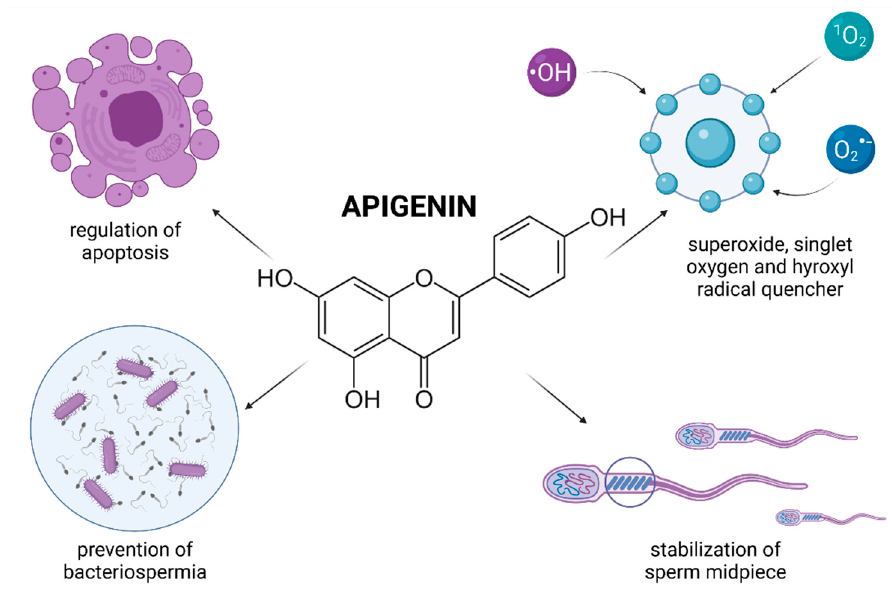
Figure 8. Most frequently reported beneficial effects of apigenin on spermatogenesis, sperm structural integrity and functional activity.